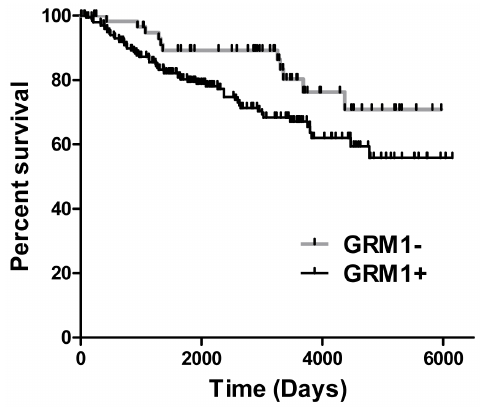
Figure 6. DMFS as a function of GRM1 mRNA expression in breast cancer patients treated with tamoxifen. Kaplan-Meier curve describing distant metastasis free survival (DMFS) of 268 patients, with ER-positive breast cancer, treated with tamoxifen as a function of GRM1 expression. Curve is generated from reanalysis of data from Loi et al. [32]. 68 patients are in the low GRM1 expressor group (GRM1-); 200 patients are represented in the high GRM1 expressing group (GRM1 +